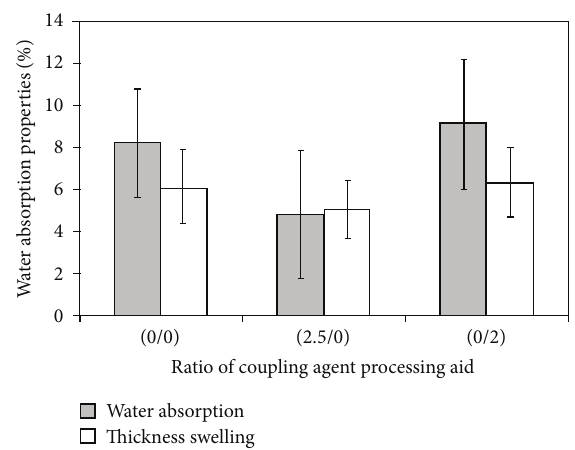
Figure 6: Tensile and flexural modulus of the composites with and without process additives